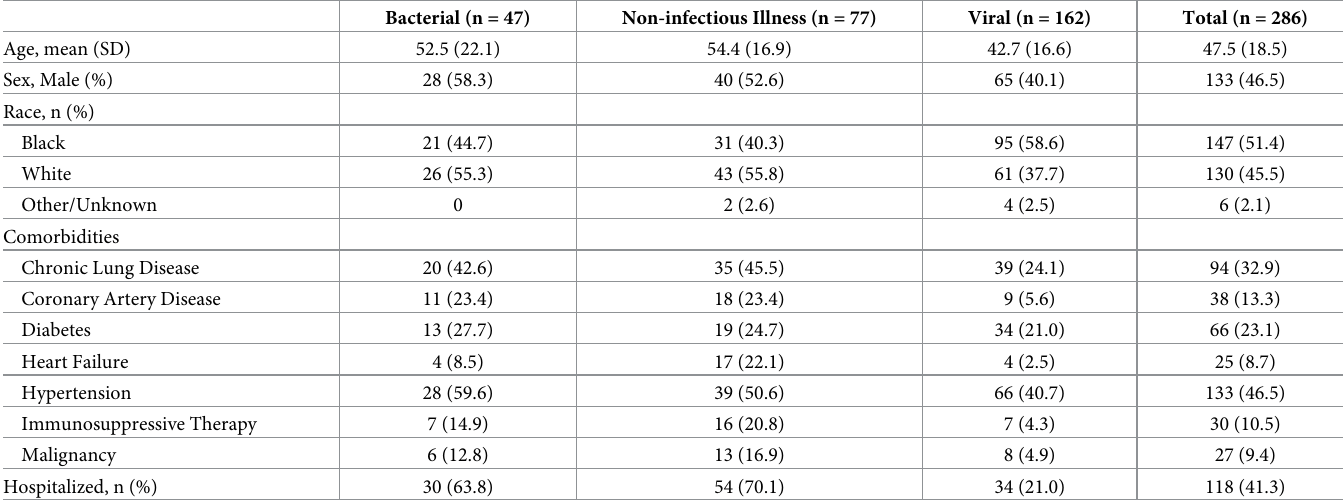
Table 1. Subject